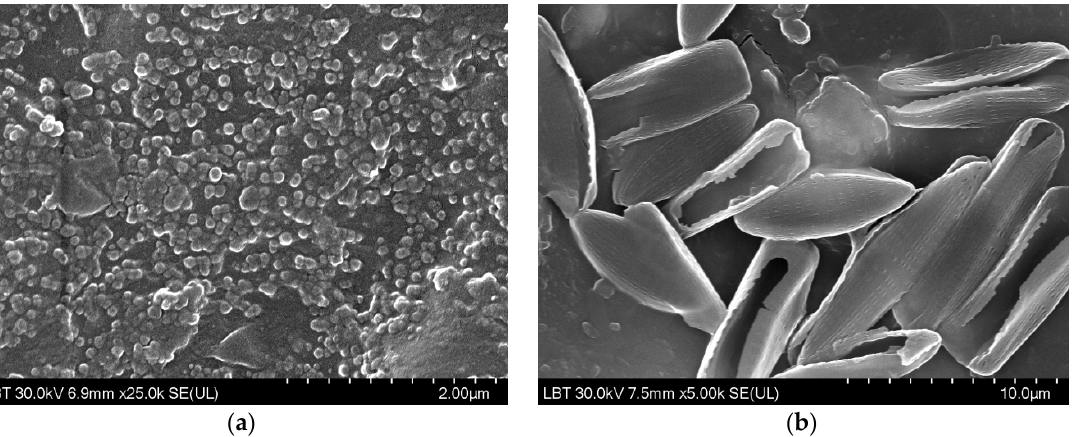
Figure 13. Higher magnification SEM images of ( a ) Chlorella biofilm on the 5% nano-ZnO-ABS and ( b ) Navicula biofilms on the 5% micro-ZnO-ABS, 3D printed composites.